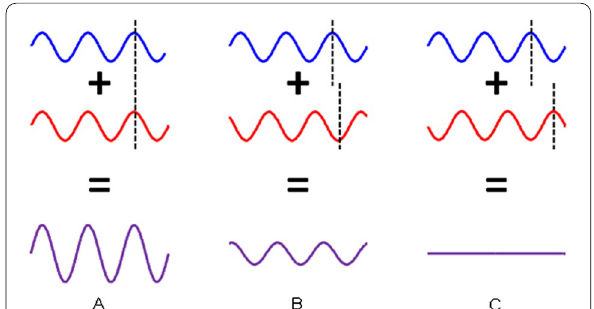
Fig. 6 Illustration of the concept of constructive and destructive wave interferences. a Constructive wave interference occurs when both interfering waves (in blue and red) are in phase (i.e., aligned as indicated by the dashed line); the resulting wave (in purple) has doubled its amplitude. b Partial destructive wave interference observed when both interfering waves are phase delayed (as indicated by nonmatching dashed lines); in that case, the resulting wave (in purple) has a lower amplitude than both interfering waves (in blue and red). c A complete destructive wave interference occurring when both interfering waves are phase shifted to obtain a maximum when the other wave has reached its minimum (as indicated by dashed lines); in this case, the resulting wave (in purple) has zero